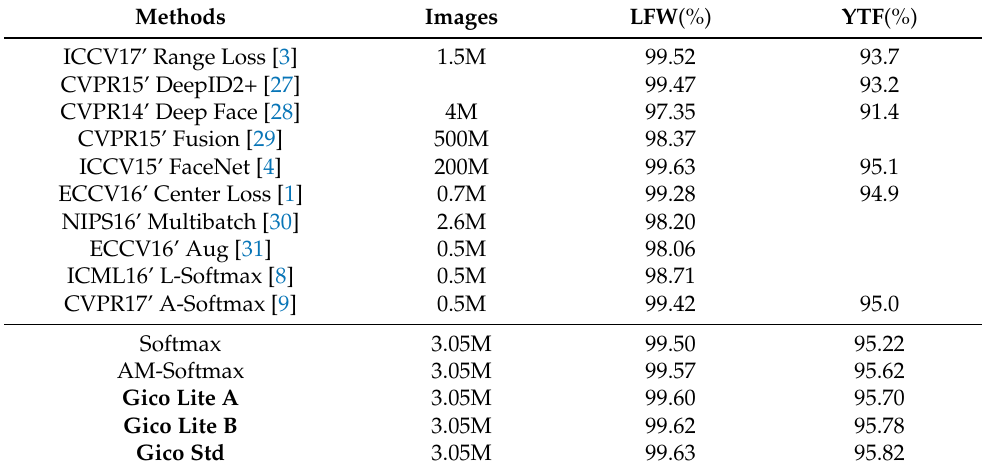
Table 4. Verification performance of state-of-the-art methods on LFW and YTF datasets.